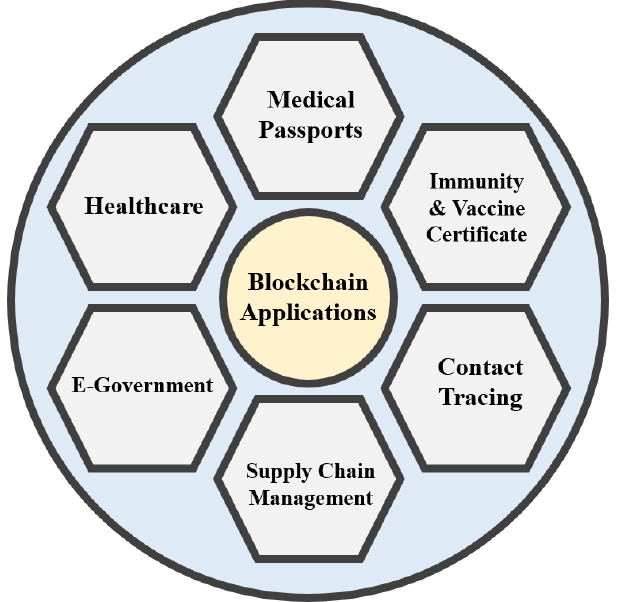
Figure 1. Blockchain-supported healthcare-related application areas in a pandemic situation.